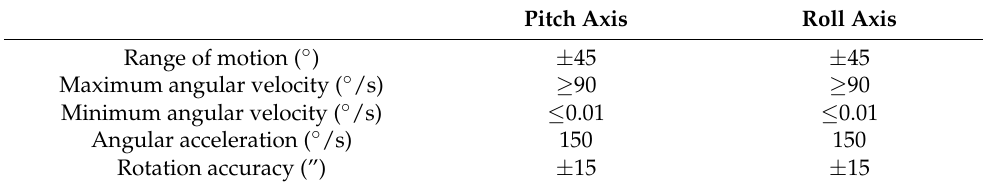
Table 1. Main technical parameters of the two-axis simulation test bench.